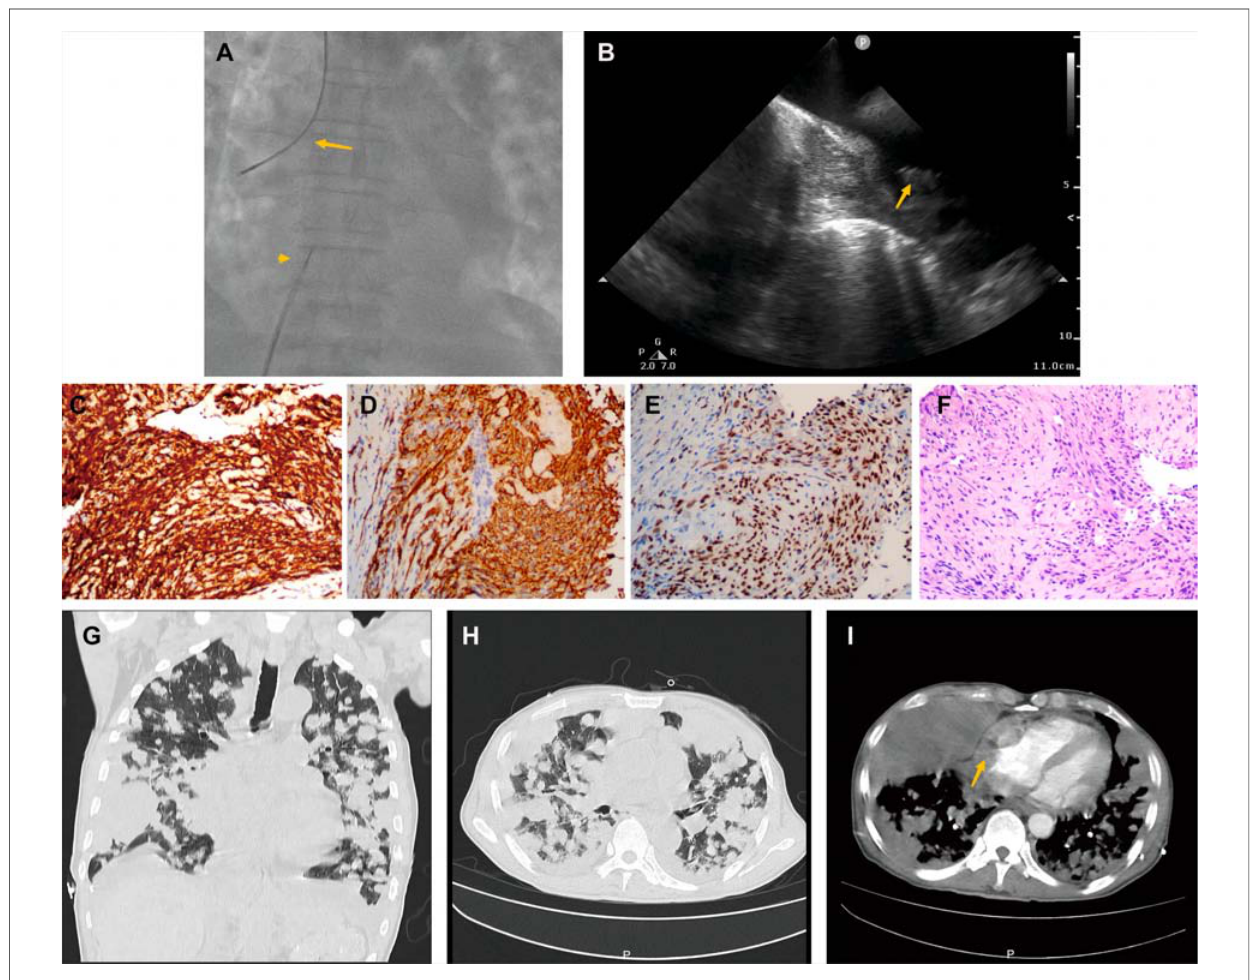
FIGURE 2 Histological endomyocardial biopsy specimen of the right atrium and lung rapid deterioration of Case1. ( A ) Catheter for intracardiac echocardiography (arrowhead) and cardiac bioptome (arrow). ( B ) The intracardial echocardiography demonstrates the mass of the right atrium and well-targeted biopsy catheter (arrow) on the mass. ( C – F ) The representative histologic aspect of the mass. Immunohistochemical staining for CD31( C ), CD34 ( D ), and ERG ( E ) marker in cytoplasmic. ( F ) Cells displaying epithelioid morphology, large nuclei, and ample cytoplasm (hematoxylin and eosin). (Original magni fi cation 40X). ( G,H ) Axial and coronal contrast-enhanced CT scans showed rapid progression of lung metastases, and ( I ) recurrent bloody pleural effusion one month after hospitalization. The arrow indicates progressive RA